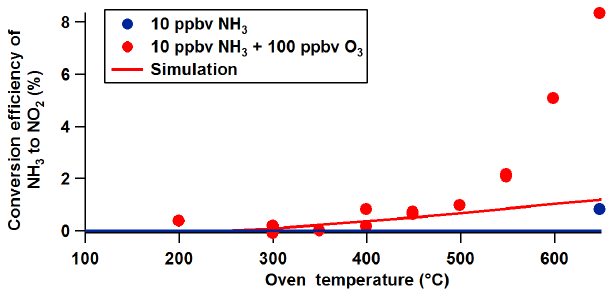
Figure 8. Thermogram of NH 3 taken with the NOAA TD-CRDS, with 100ppbv of O 3 added before the oven shown as red circles. The blue circle represents an analogous measurement at 650 ◦ C with no O 3 added. Kinetic box model simulations shown in solid lines of corresponding